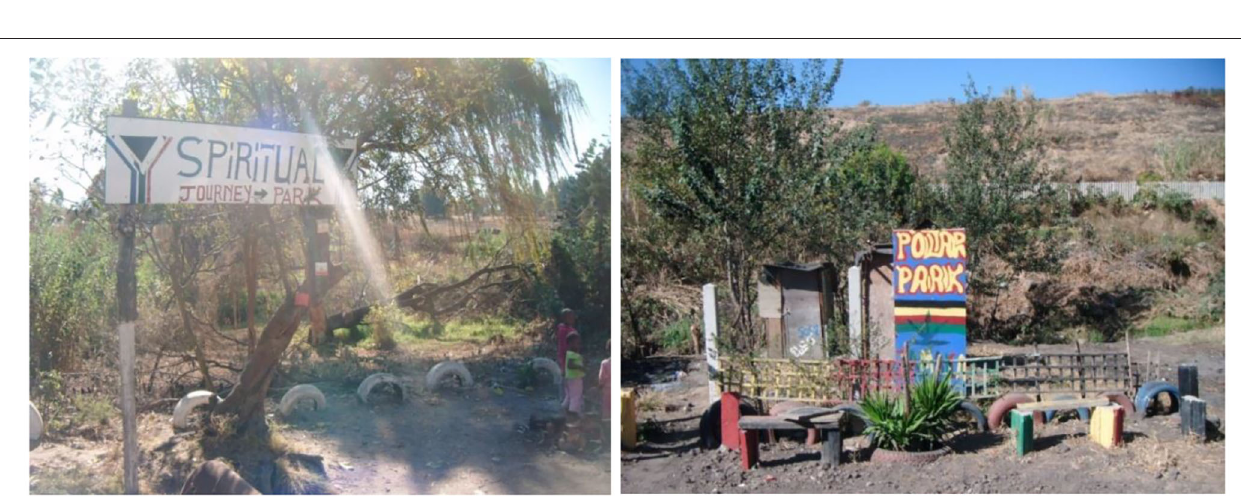
FIGURE 2 | Self-built parks within a settlement in Johannesburg. Source: Author’s Photo, taken in